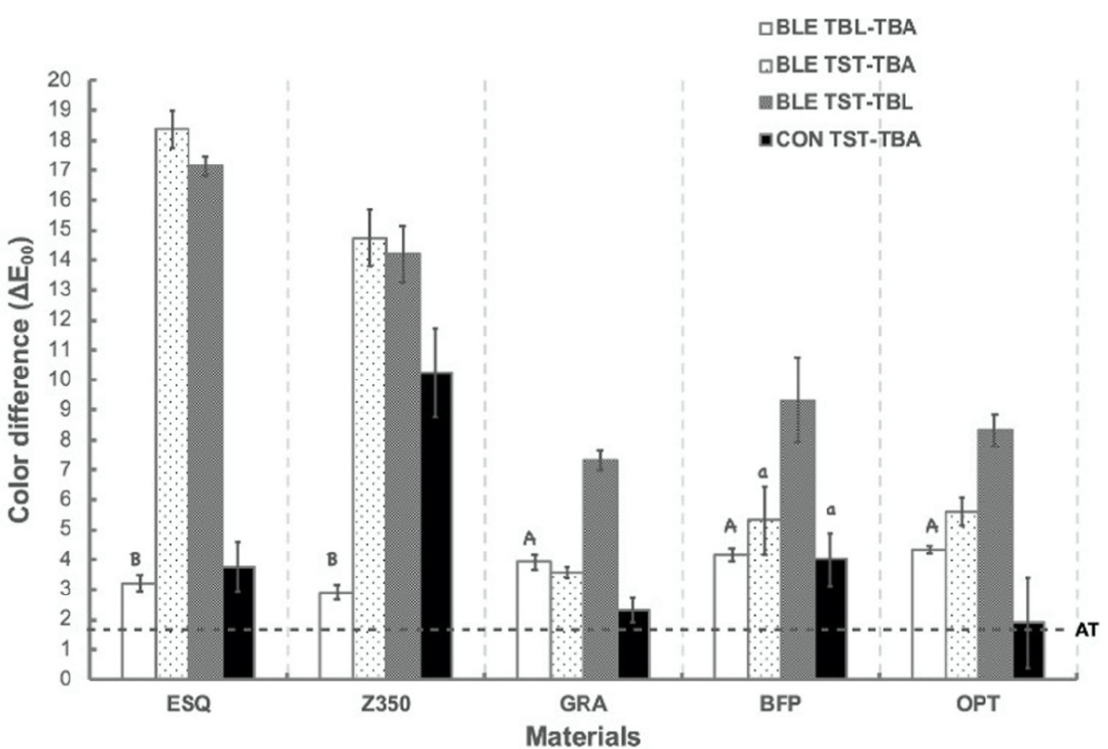
Figure 3. Mean and standard deviation values of color differences ( ∆ E ab *) between 2 different measuring time points (T BL -T BA , T ST -T BA , and T ST -T BL ) for each material from the BLA and CON groups. Dashed line at 2.7 represents the acceptability threshold (AT) [8]. Same capital letter indicates no static difference between materials. Same lowercase letter indicates no static difference between time points for each material.